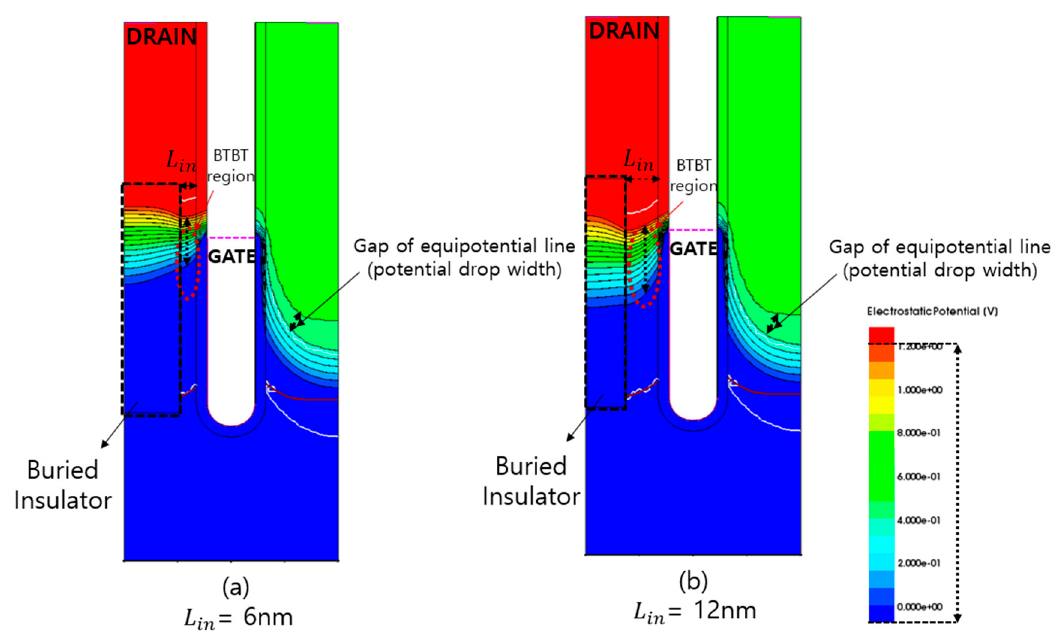
Figure 8. Electrostatic potential distribution according to the L in of Pi-BCAT.